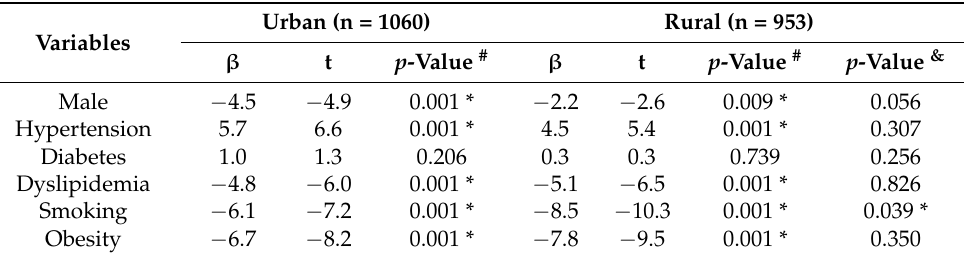
Table 3. Multiple linear regression analysis for association of conventional risk factors and the onset age of AMI for urban and rural